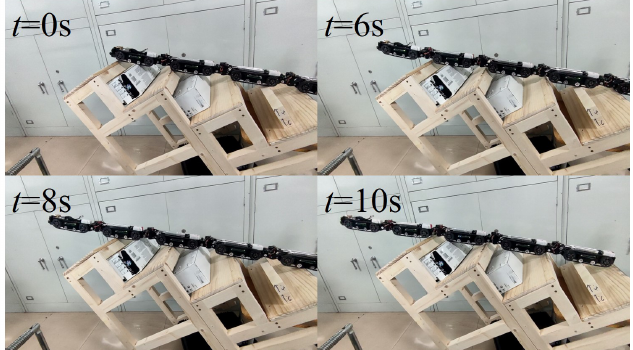
Figure 21. The entity assembled of five modules climbing up a stair with a 20 ◦ angle of